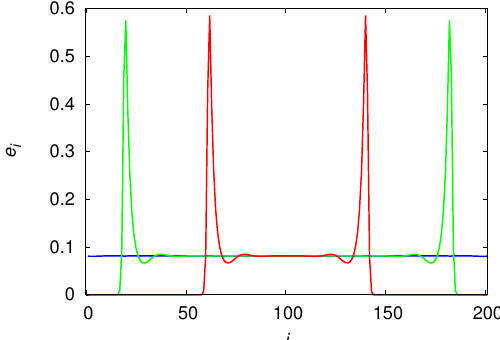
Figure 3. Density of engineers in patch i = 1, . . . , N at times t / N = 1 (red line), t / N = 2 (green line) and t / N = 3 (blue line). The chain size is N = 201 and the model parameters are r = 1, α = 1, δ = 0.1, ρ = 0.01 and µ =